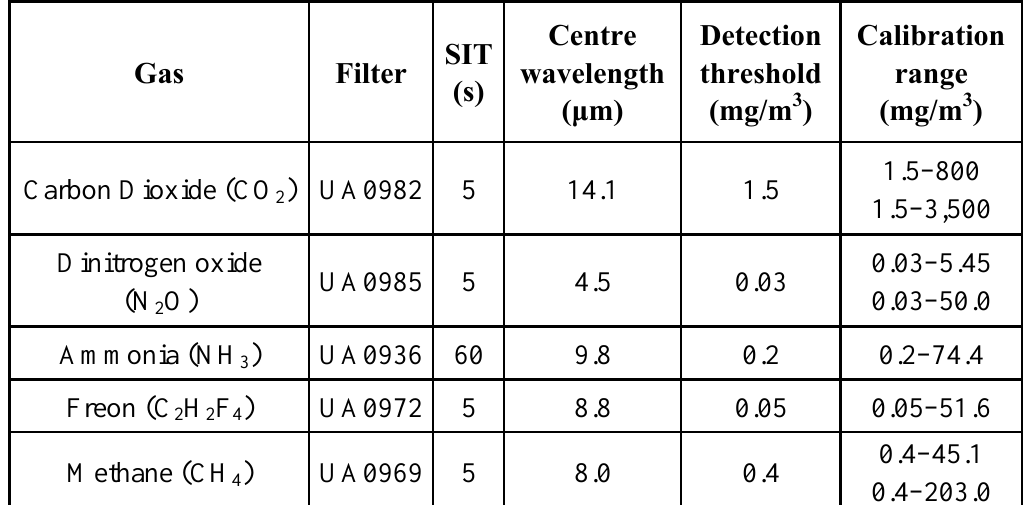
Table 1 . Filter setup in the Multi Gas Monitor